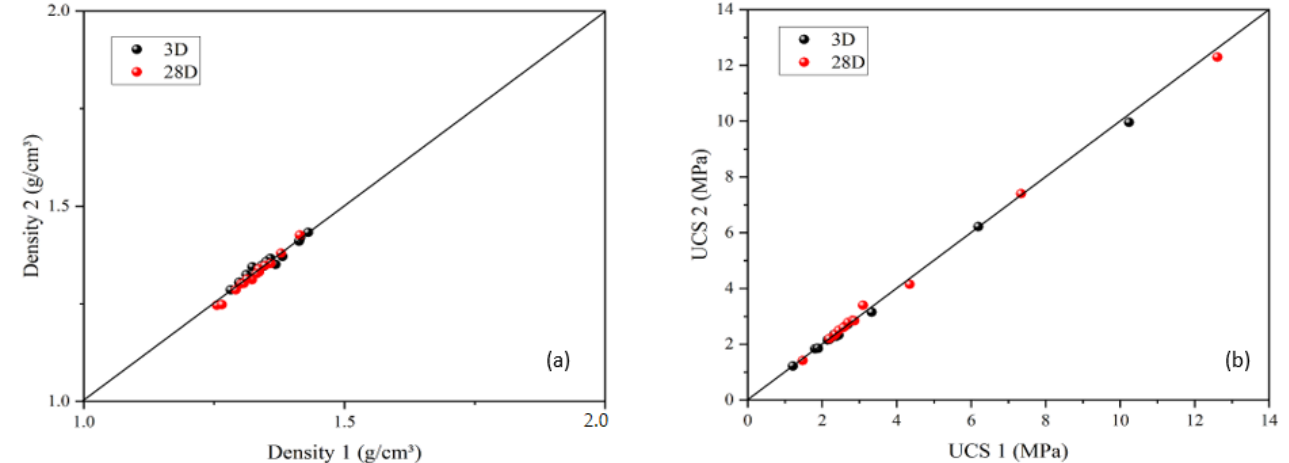
Figure 4. Verification of each specimen in terms of slurry density ( a ) and UCS ( b ).